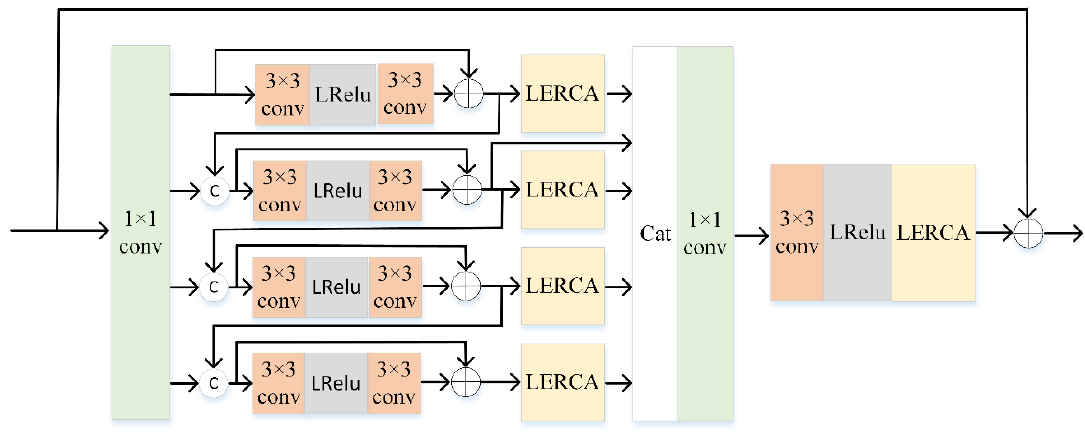
Figure 2. Internal structure diagram of multibranch feature multiplexing fusion attention block